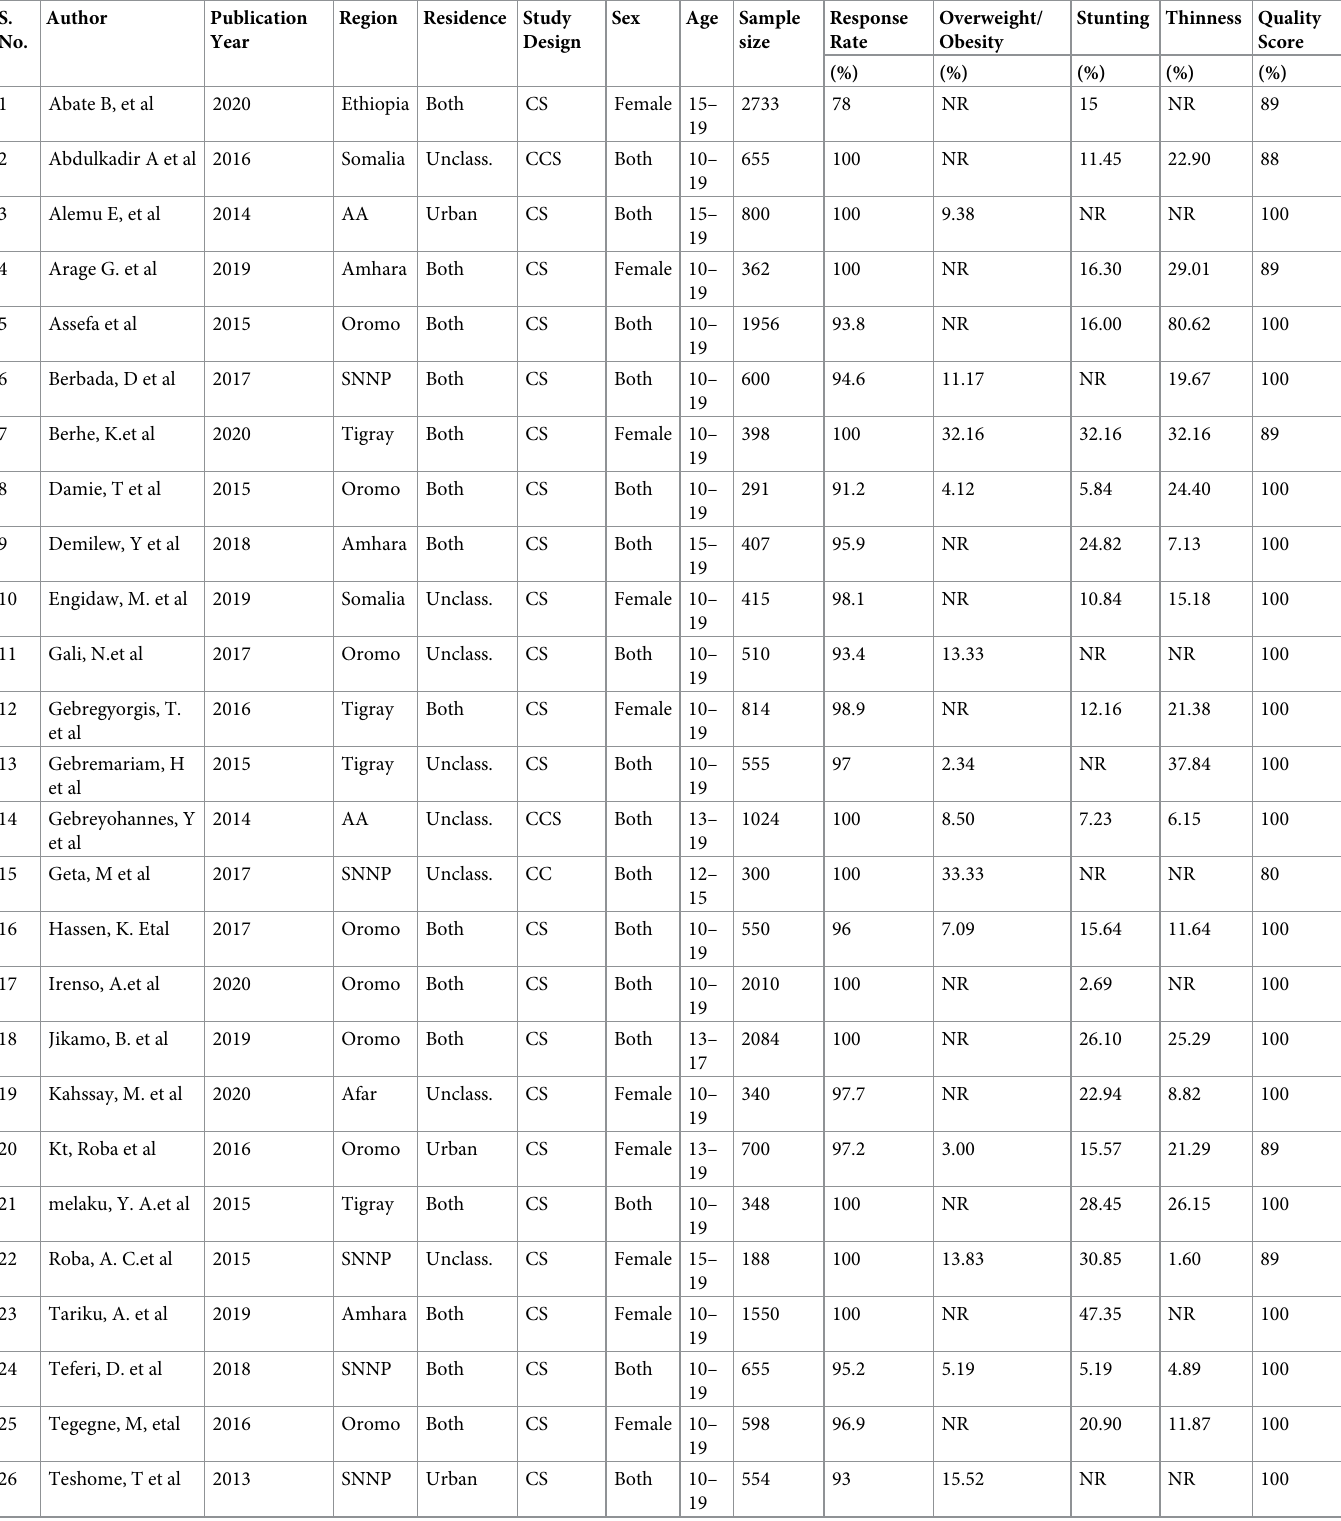
Table 3. Summary of extracted studies in the analysis of prevalence and associated factors of adolescent’s malnutrition in